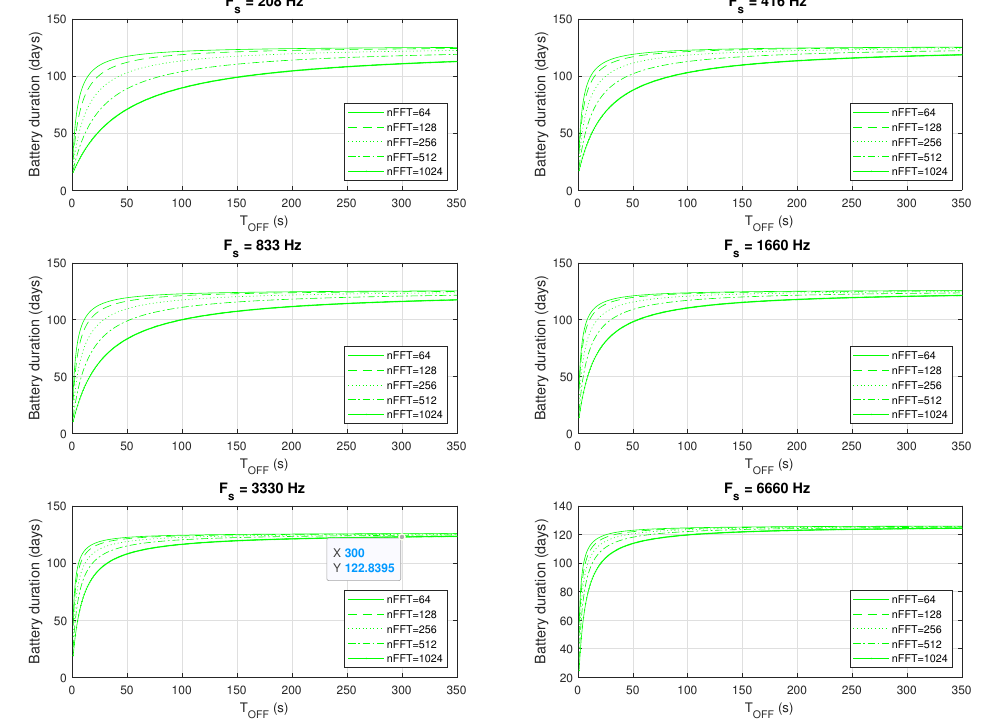
Figure 16. Battery duration for RT controller and operating mode T OFF >